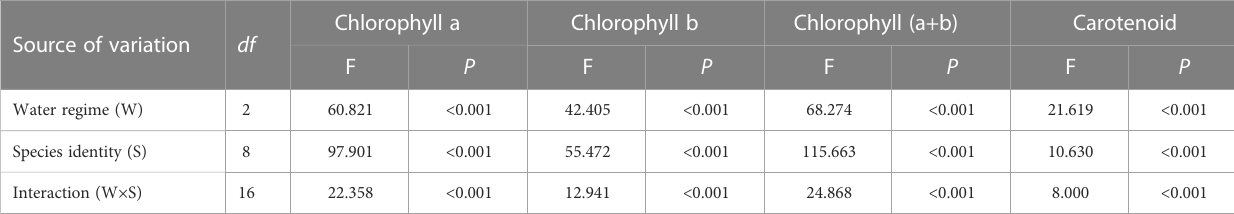
TABLE 3 Results of two-way ANOVAs examining the major and interactive effects of water regime and plant species identity on the contents of photosynthetic pigments.